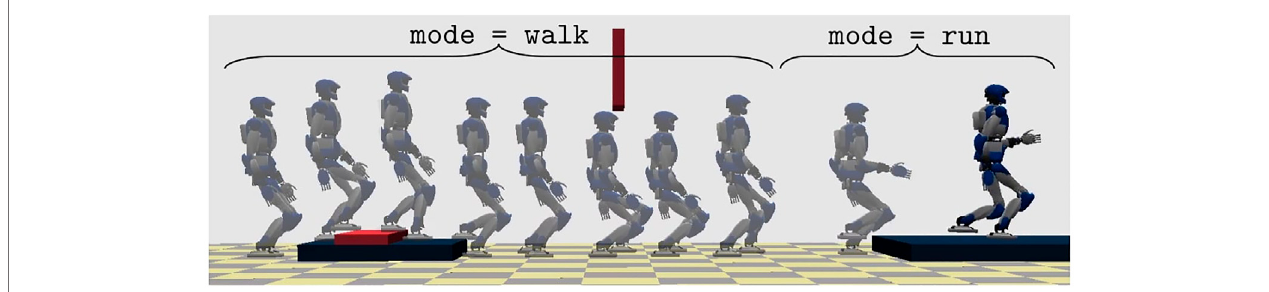
FIGURE 13 | Walking and running in a world of stairs: stroboscopic